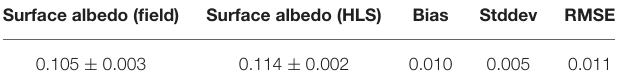
TABLE 1 | Validation of the HLS albedo with field measurements. Surface albedo (field) Surface albedo